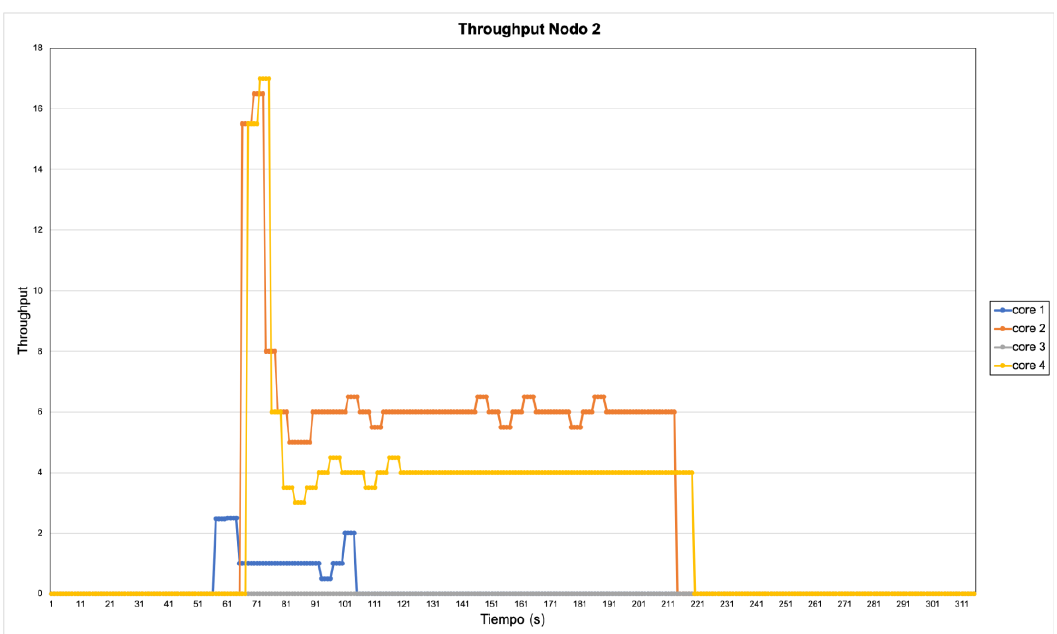
Figure 16. RPI node 2 power consumption.